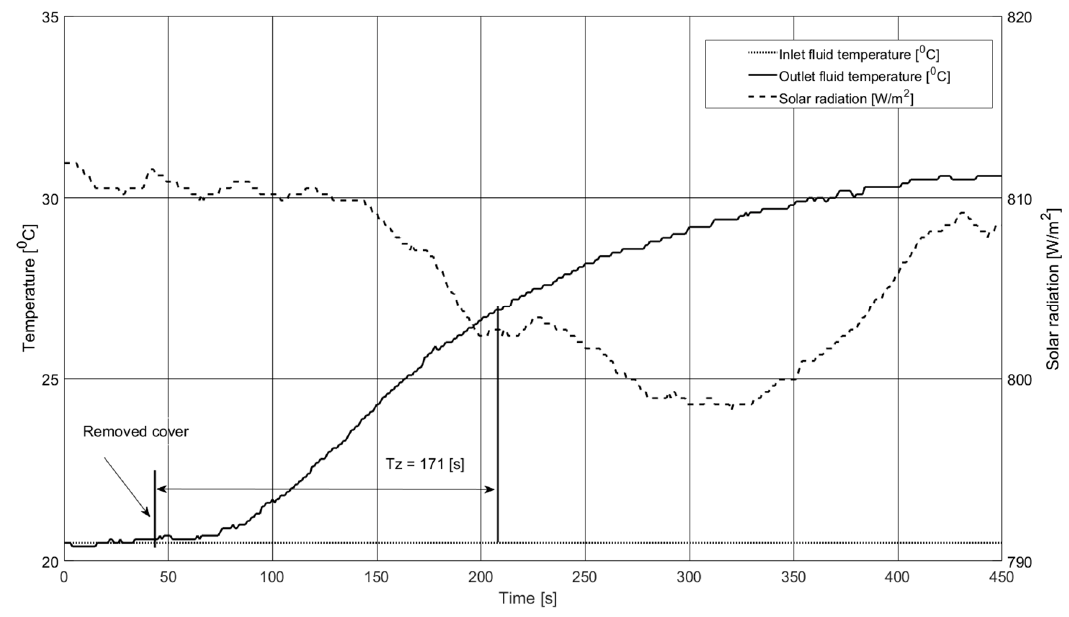
Figure 7. The step response of the collector determined according to the ISO 9806:17 standard under outdoor conditions.